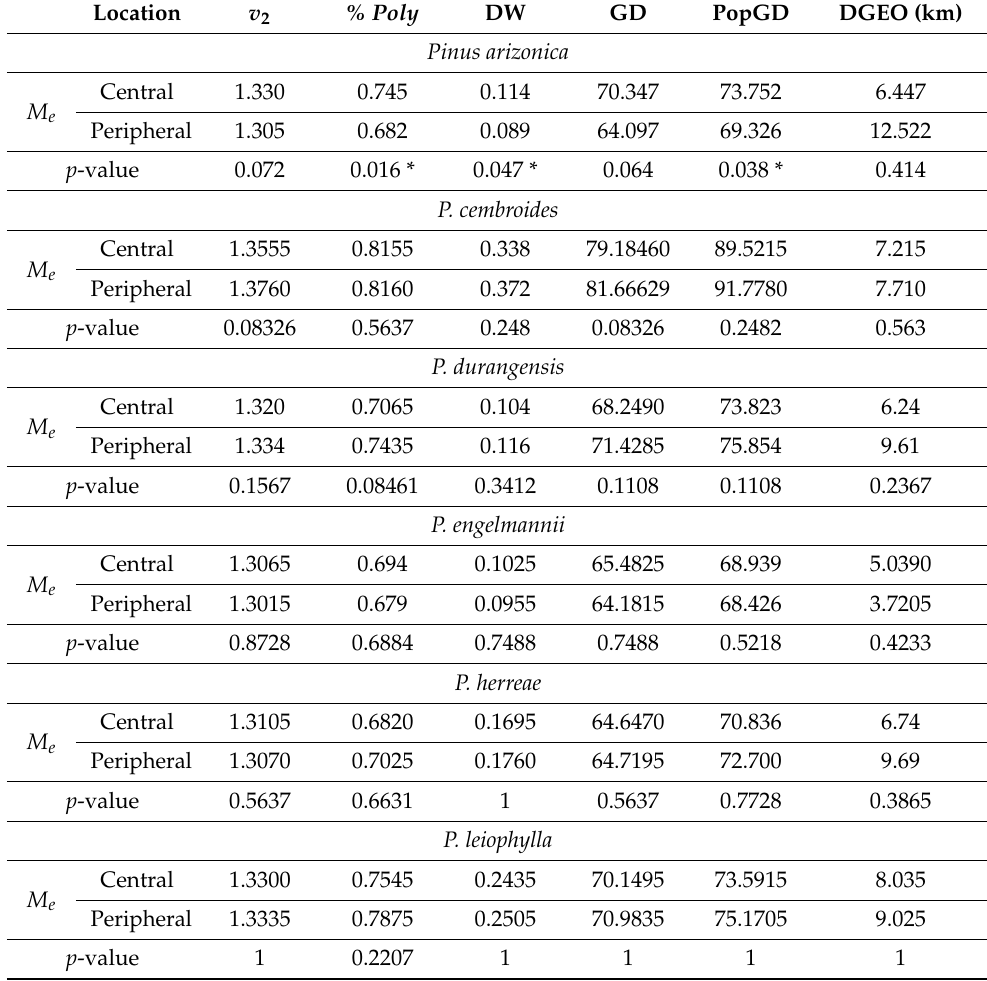
Table 8. Comparison of the differences between central and peripheral populations according to criterion 2 using the non-parametric Kruskal–Wallis